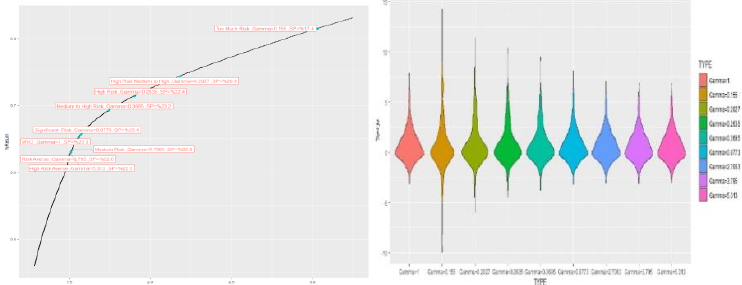
Figure 5 . Efficient and violet boundary for training data and position of selected portfolios for different gamma values (research findings)